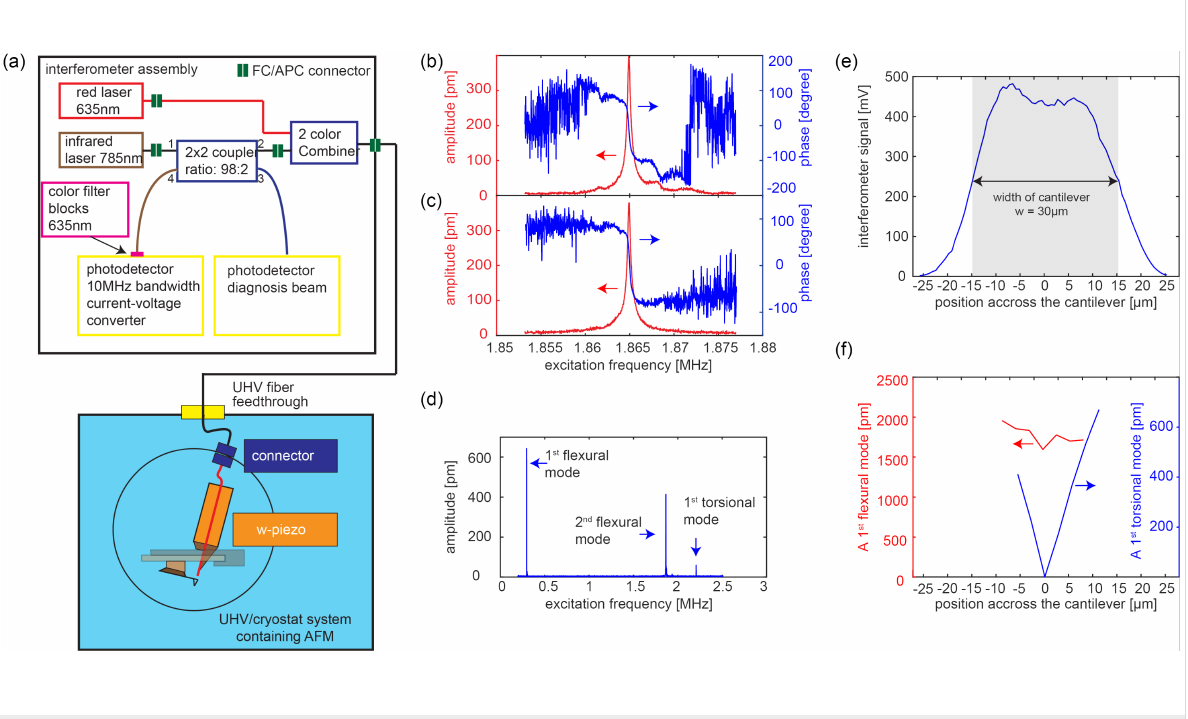
Figure 8: (a) Setup of the interferometer system. (b, c) Amplitude and phase as a function of the frequency for mechanical and optical cantilever exci- tation, respectively. (d) Wide frequency range mechanical excitation spectrum of the cantilever showing the first and second flexural and first torsional resonances. (e) Interferometer signal as a function of the fiber position across the cantilever (displayed schematically by the gray area). (f) Measured oscillation amplitudes of the cantilever for the first flexural (red) and first torsional oscillation modes (blue), respectively. The torsional oscillation modes vanish if the fiber is positioned above the central axis of the